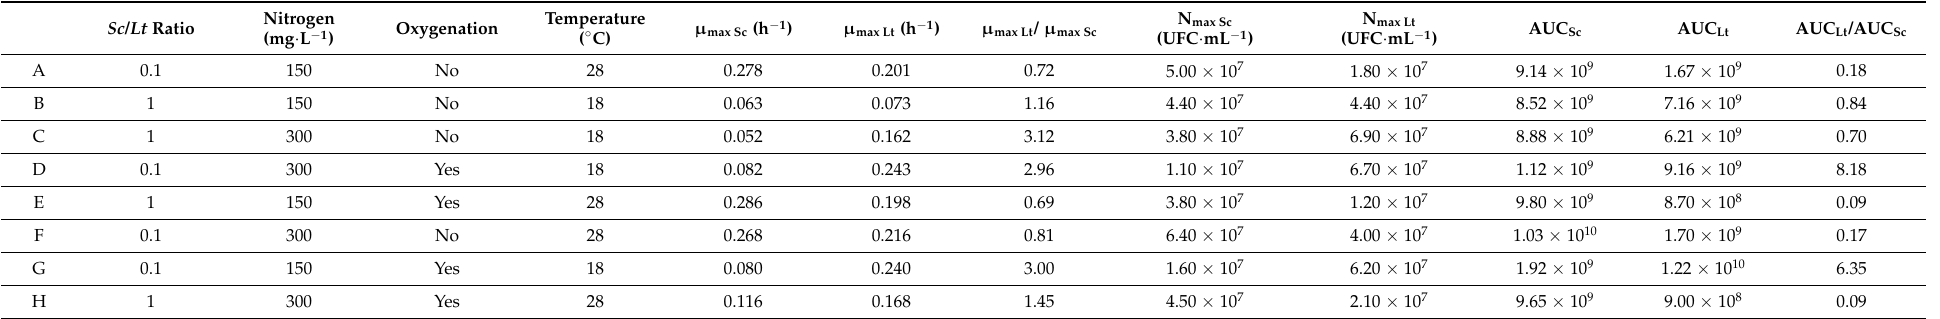
Table A1. Quantitative data related to population dynamics in the different conditions of the experimental design (A to H): maximal population (N max ),